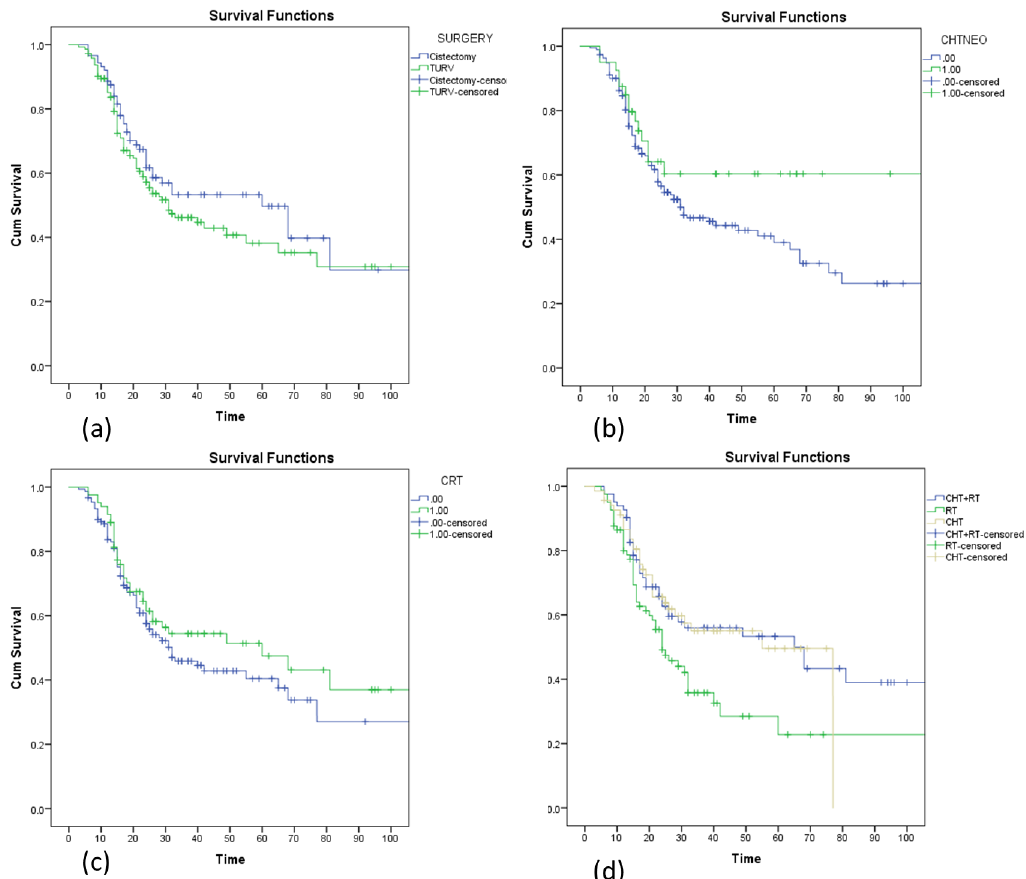
Figure 3. Kaplan–Meier curve assessing the disease-free survival ( a ) in patients who underwent surgery vs. TURBT, ( b ) in patients who underwent definitive chemoradiotherapy (CHT-RT) vs. neoadjuvant chemotherapy (CHT) vs. just radiotherapy (RT), ( c ) in patients who received definitive chemoradiotherapy, and ( d ) in patients who received neoadjuvant chemotherapy (CHTNEO) .